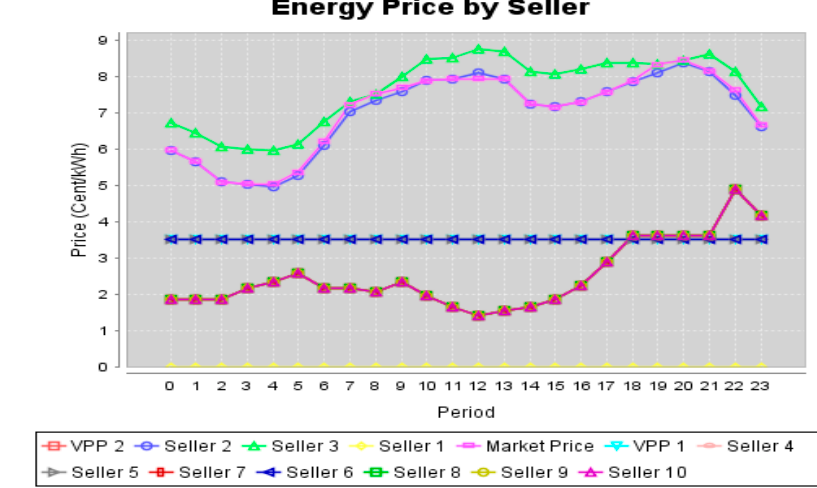
Figure 9. Evolution of the sellers’ o ff er price and the market price. Table 2. Results of the o ff er made by Seller 2 in the second